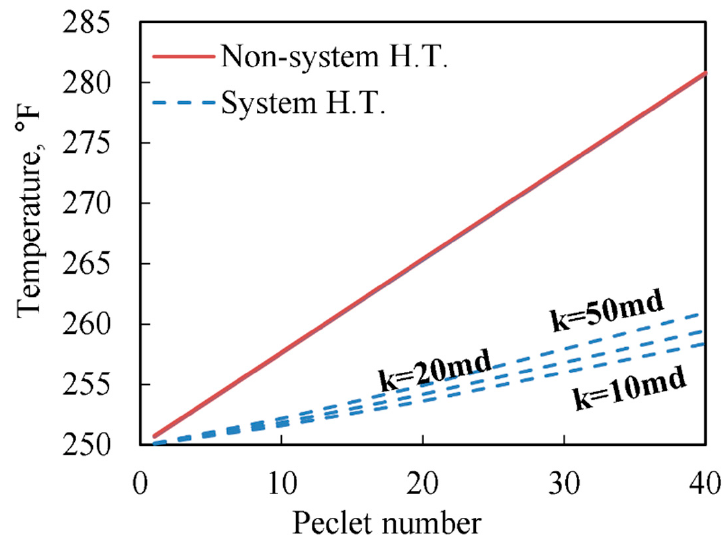
Figure 9. Wellbore wall temperature with Peclet number at different permeabilities.